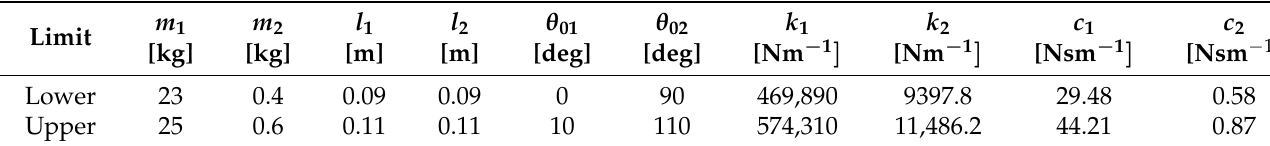
Table 2. Lower and upper limit.